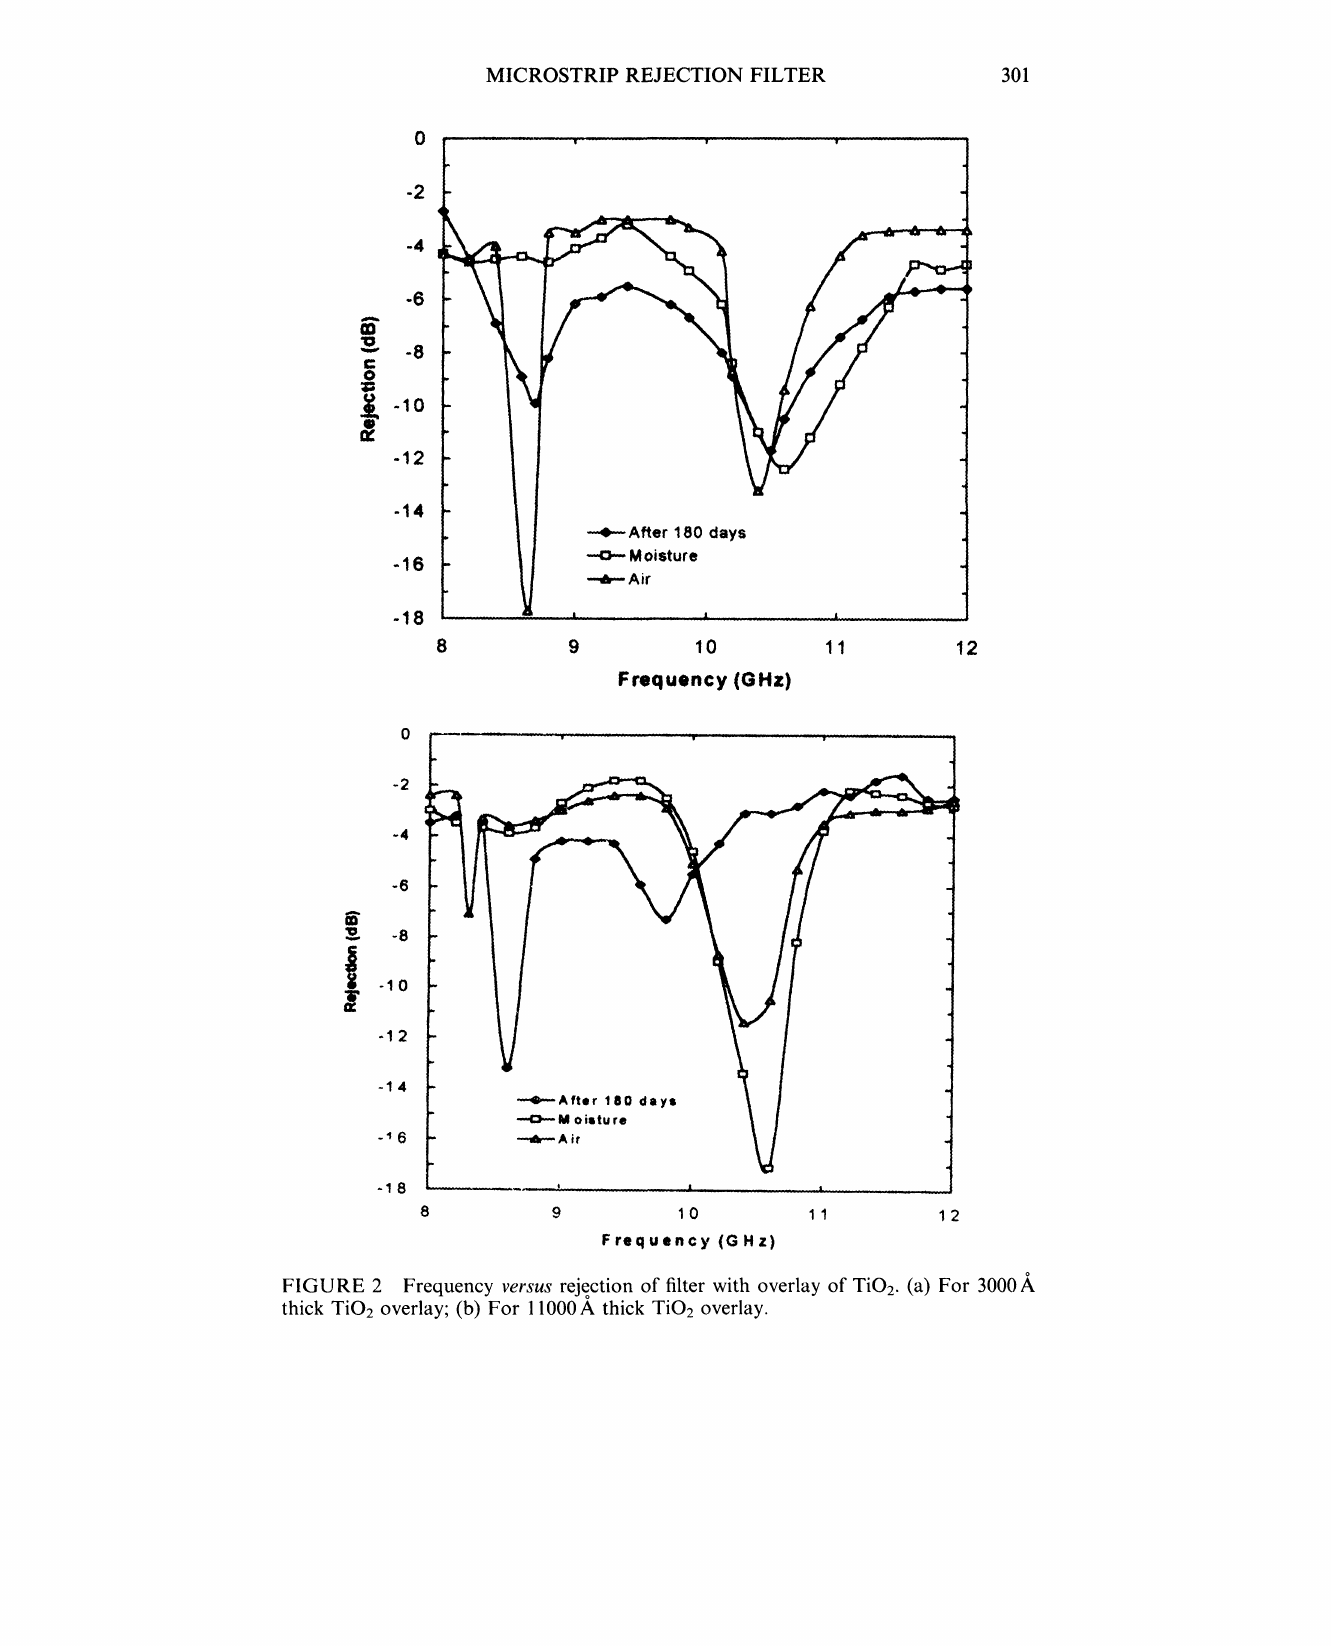
FIGURE 2 Frequency versus rejection of filter with overlay of TiO2. (a) For 3000 thick TiO2 overlay; (b) For 11000 A thick TiO2